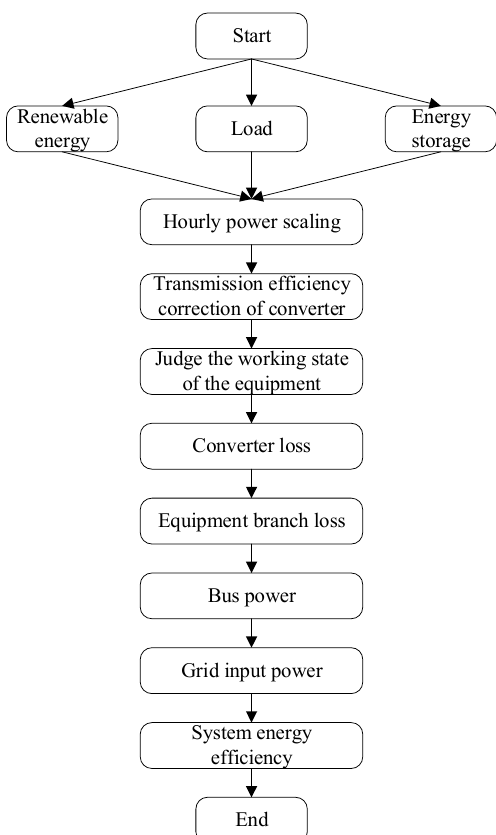
Figure 2. The flow chart of system energy efficiency evaluation.